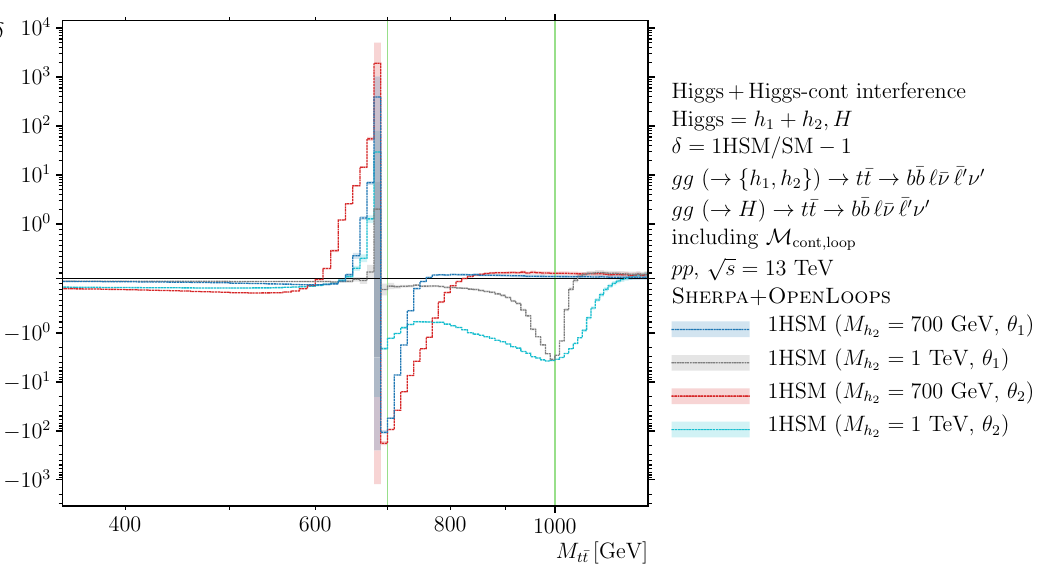
distributions of the relative deviation δ = R t ¯ t ) t ¯ t b ¯ b (cid:21) ¯ ν ¯ (cid:21) (cid:31) ν (cid:31) in pp collisions at √ s = 13 TeV. R is the ratio of h 1 , h 2 , H } → → → {